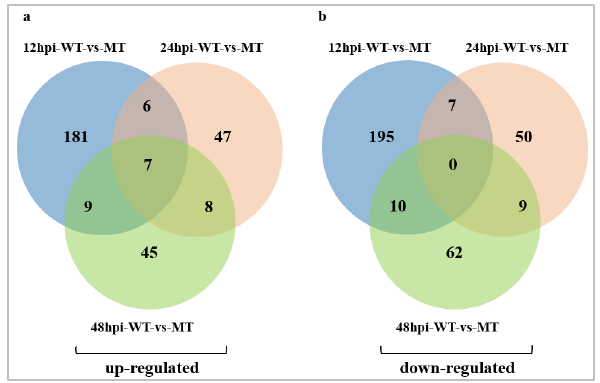
Figure 2. Venn diagram of DEGs distribution between WT-vs-MT at different time points. ( a ) The Venn diagram showing the overlapping up-regulated DEGs at different time points. ( b ) The Venn diagram showing the overlapping down-regulated DEGs at different time points.